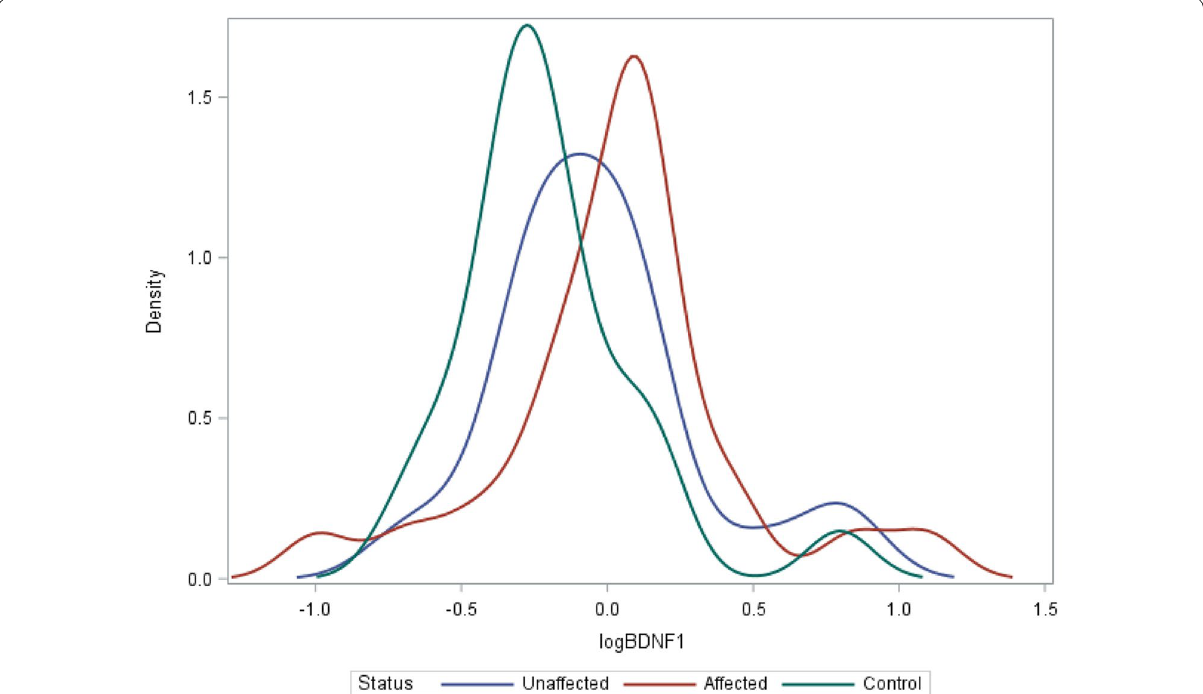
Fig. 1 Kernel smoothed log BDNF ‑ 1 methylation profiles in cross‑sectional analysis between affected and unaffected high‑risk (HR) offspring and controls. Estimated distribution of log BDNF‑1 methylation rates. After adjustment, there was evidence that the mean of controls (green) is different from the mean of unaffected HR (blue) (p that the mean of affected HR (red) was different from unaffected HR (blue) (p